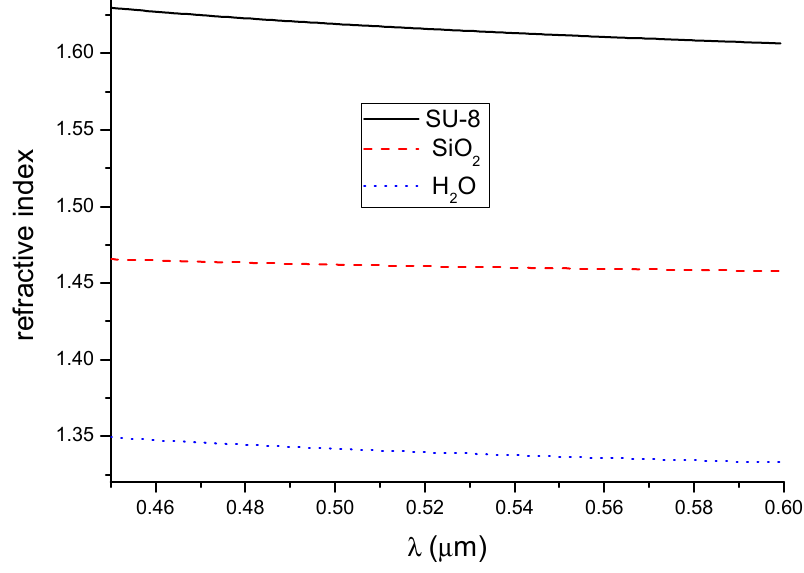
Figure 2. Dispersion in the waveguide structure.